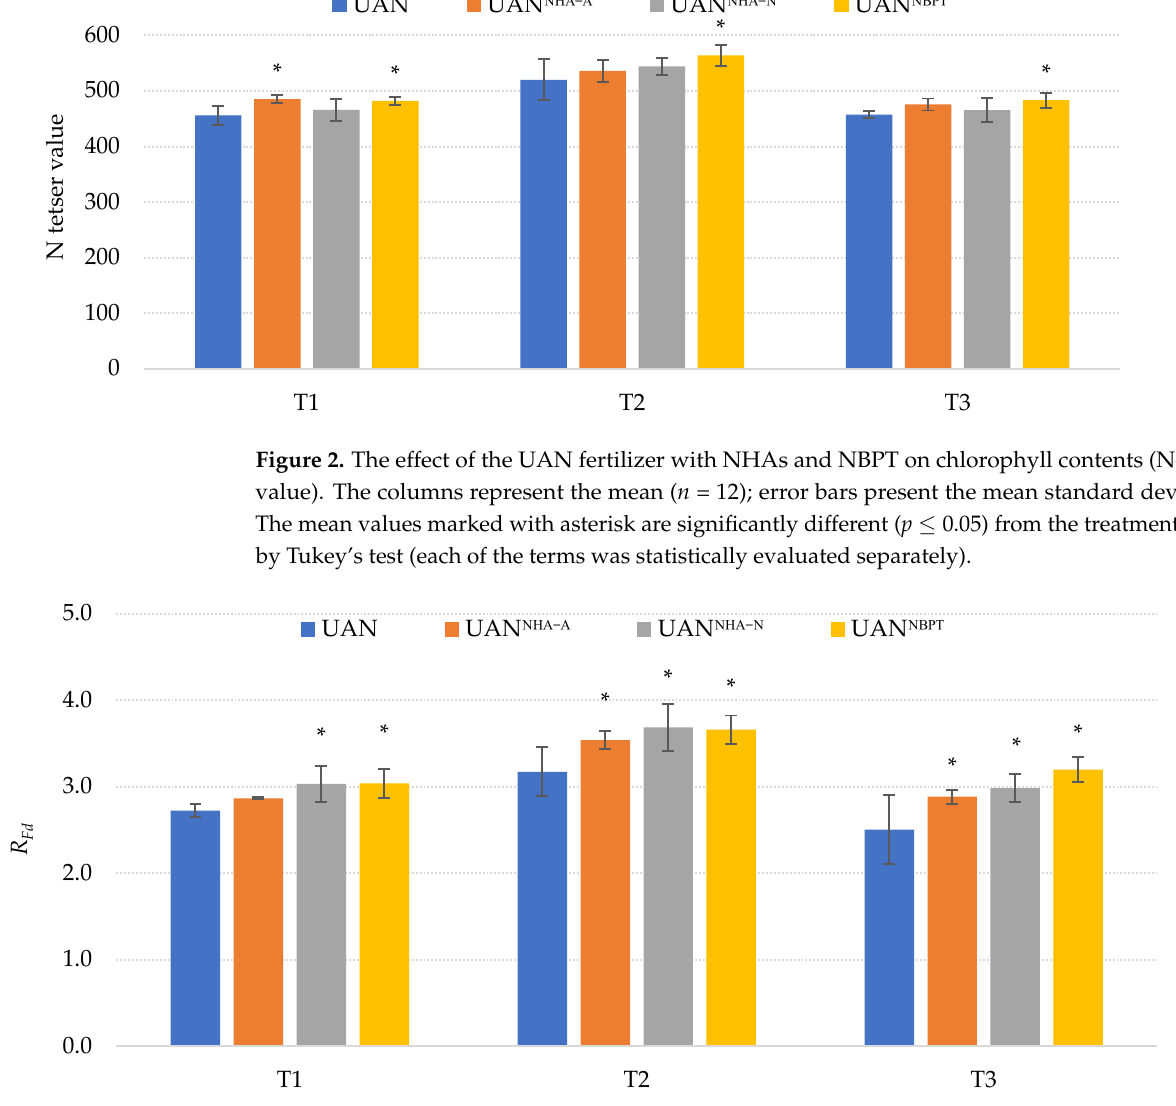
Figure 3. The effect of the UAN fertilizer with NHAs and NBPT on chlorophyll fluorescence de- crease ratio ( R Fd ). The columns represent the mean ( n = 12); error bars present the mean standard deviation. The mean values marked with asterisk are significantly different ( p ≤ 0.05) from the treat- ment UAN by Tukey’s test (each of the terms was statistically evaluated separately).